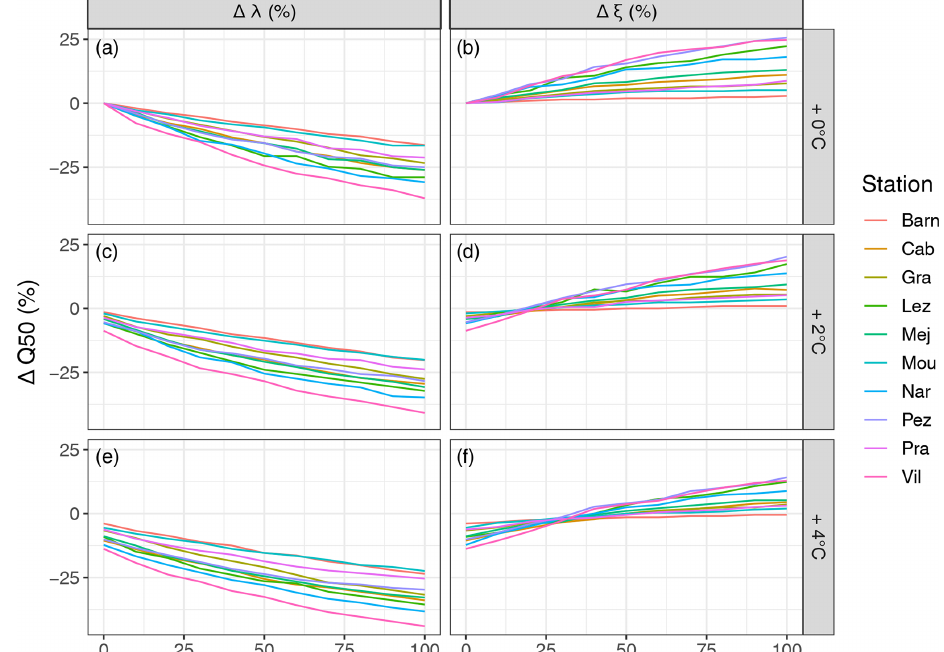
Figure 8. Sensitivity of the median of the simulated soil moisture to an increase of the precipitation intermittence (a, c, e) and to an increase of mean precipitation intensity (b, d, f) under different temperature scenarios ( + 0, + 2, + 4 ◦ C).